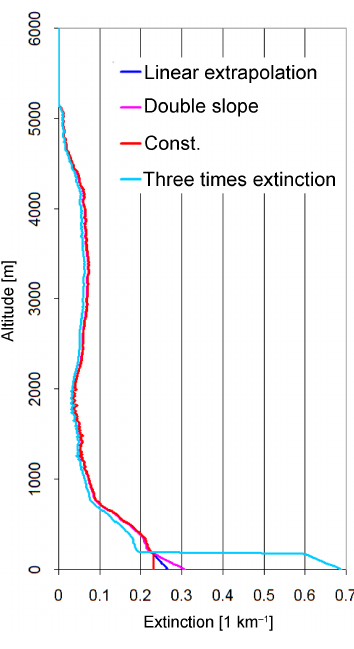
Figure A31. Aerosol profile (light blue) with extreme extinc- tion close to the surface (below 180m, the altitude for which the ceilometer is sensitive) extracted for the first period (08:00–11:00) on 18 June 2013. Also shown are the profiles extrapolated below 180 as described above. Const. means constant below 180m.